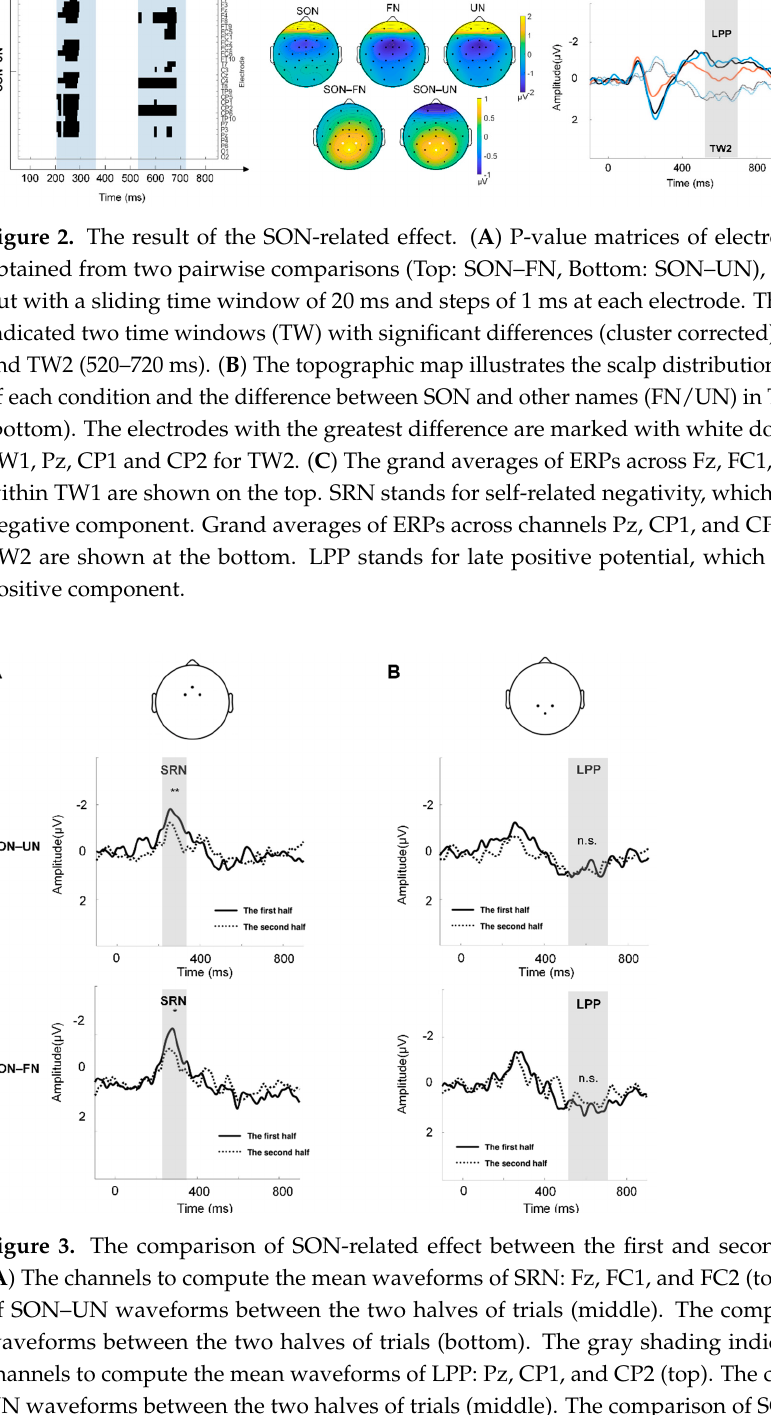
Figure 4. The grand average waveform across the channel of TW1 (Fz, FC1, FC2). ( A ) The grand average waveform of SON between the two halves of trials. ( B ) The grand average waveform of FN between the two halves of trials. ( C ) The grand average waveform of UN between the two halves of trials. *** = p < 0.001, n.s. = p > 0.05.